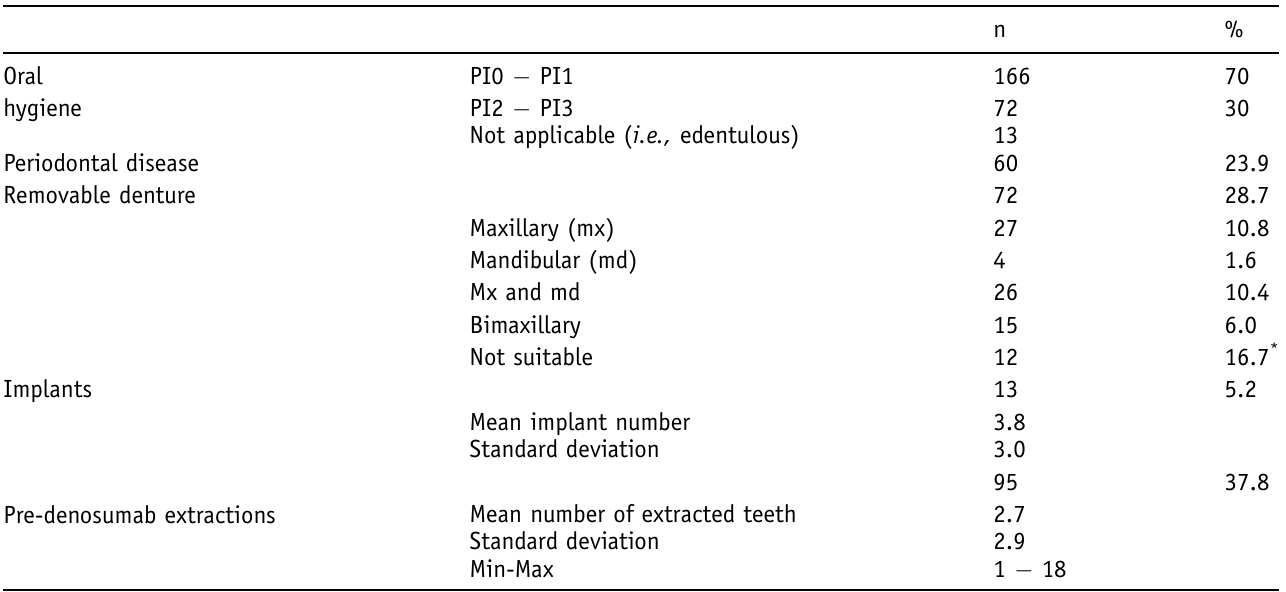
Table III. Baseline oral